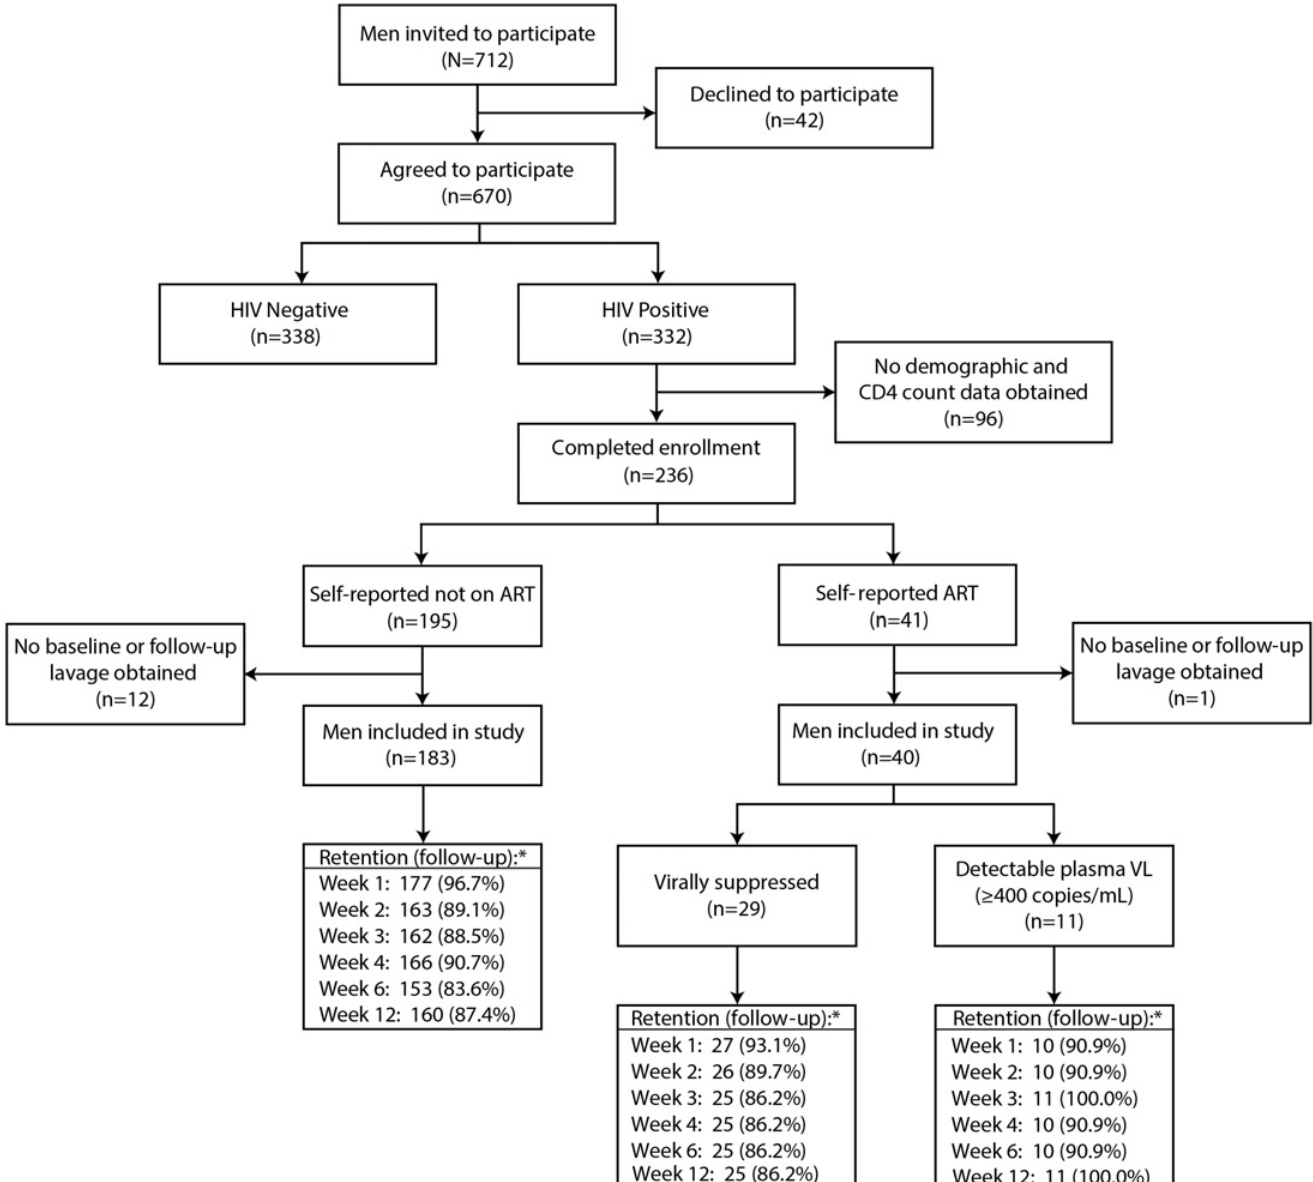
Fig 1. Study flow diagram. The retention (asterisk) indicates the number (percent) of men at each follow-up